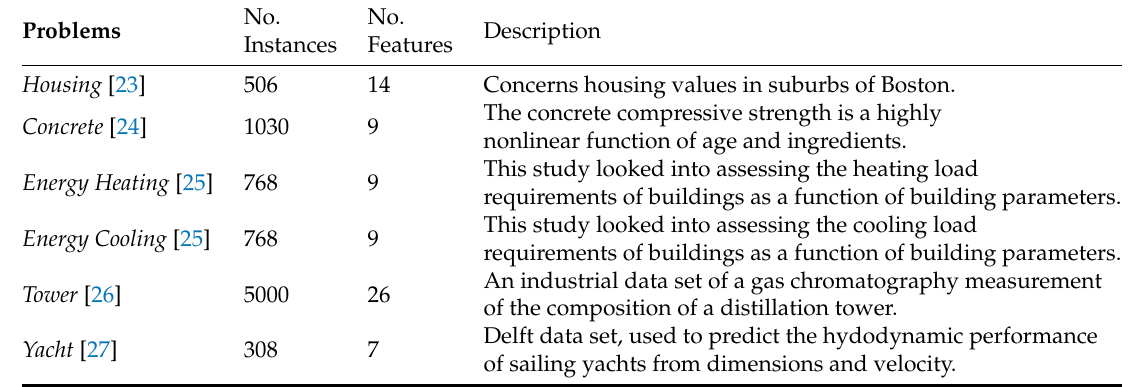
Table 1. Symbolic regression real world problems.